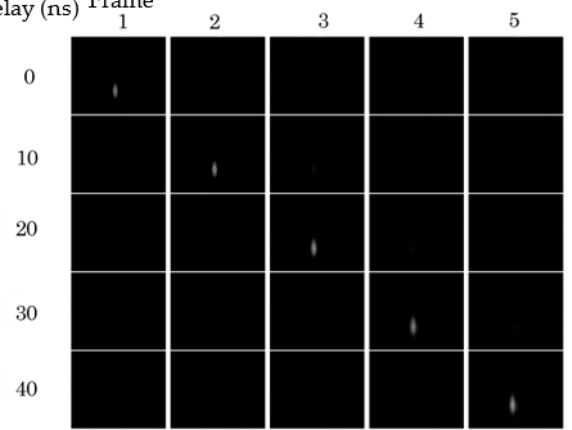
Figure 5. Evaluation of the temporal resolution: LD is applied in the middle of each frame (see Figure 6). Each row shows a sequence of five consecutive images; one LD image appears in each sequence.